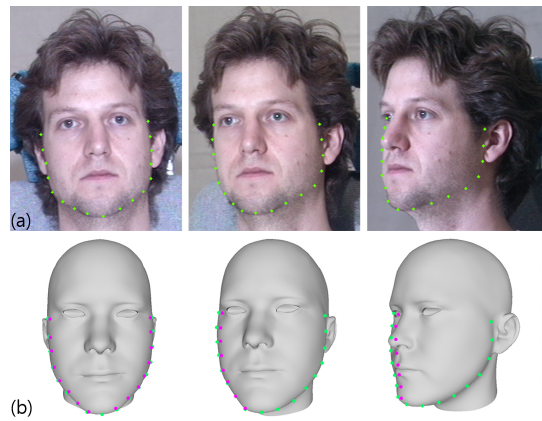
Figure 4. Differences in feature position between 2D and 3D faces with respect to pose changes: ( a ) Input images. ( b ) 3D faces. Green dots are 2D landmarks and magenta points are the corresponding 3D feature